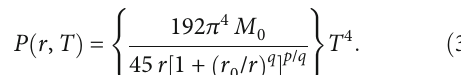
π 5 R 2 T 3 Figure 2: The horizon temperature over ½ 90 R 2 /3072 M 0 shown as a function of x = r 0 / R